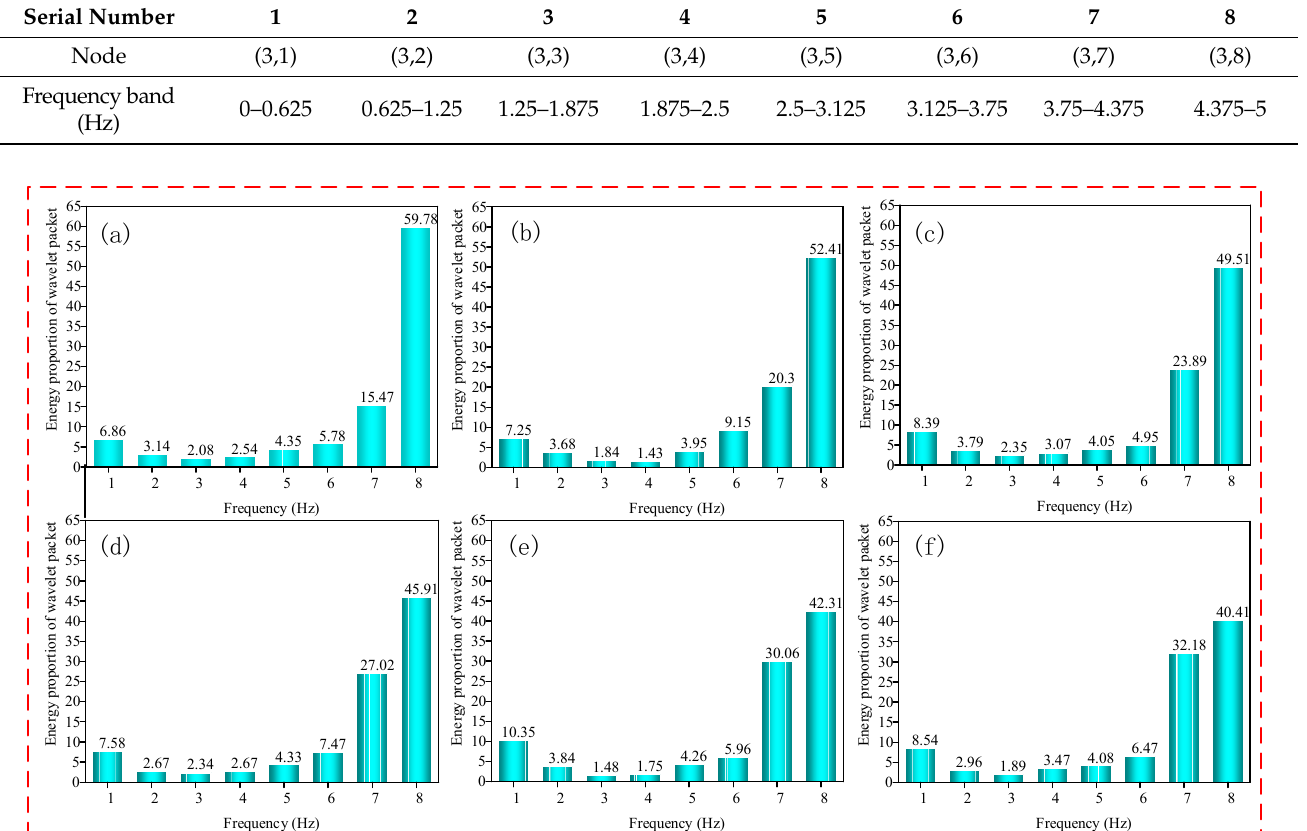
Figure 5. Proportion of wavelet packet energy in each processing stage of the FAP. Note: ( a ) Lapping time 0–30 min; ( b ) lapping time 30–60 min; ( c ) lapping time 60–90 min; ( d ) lapping time 90–120 min; ( e ) lapping time 120–150 min; ( f ) lapping time 150–180 min.